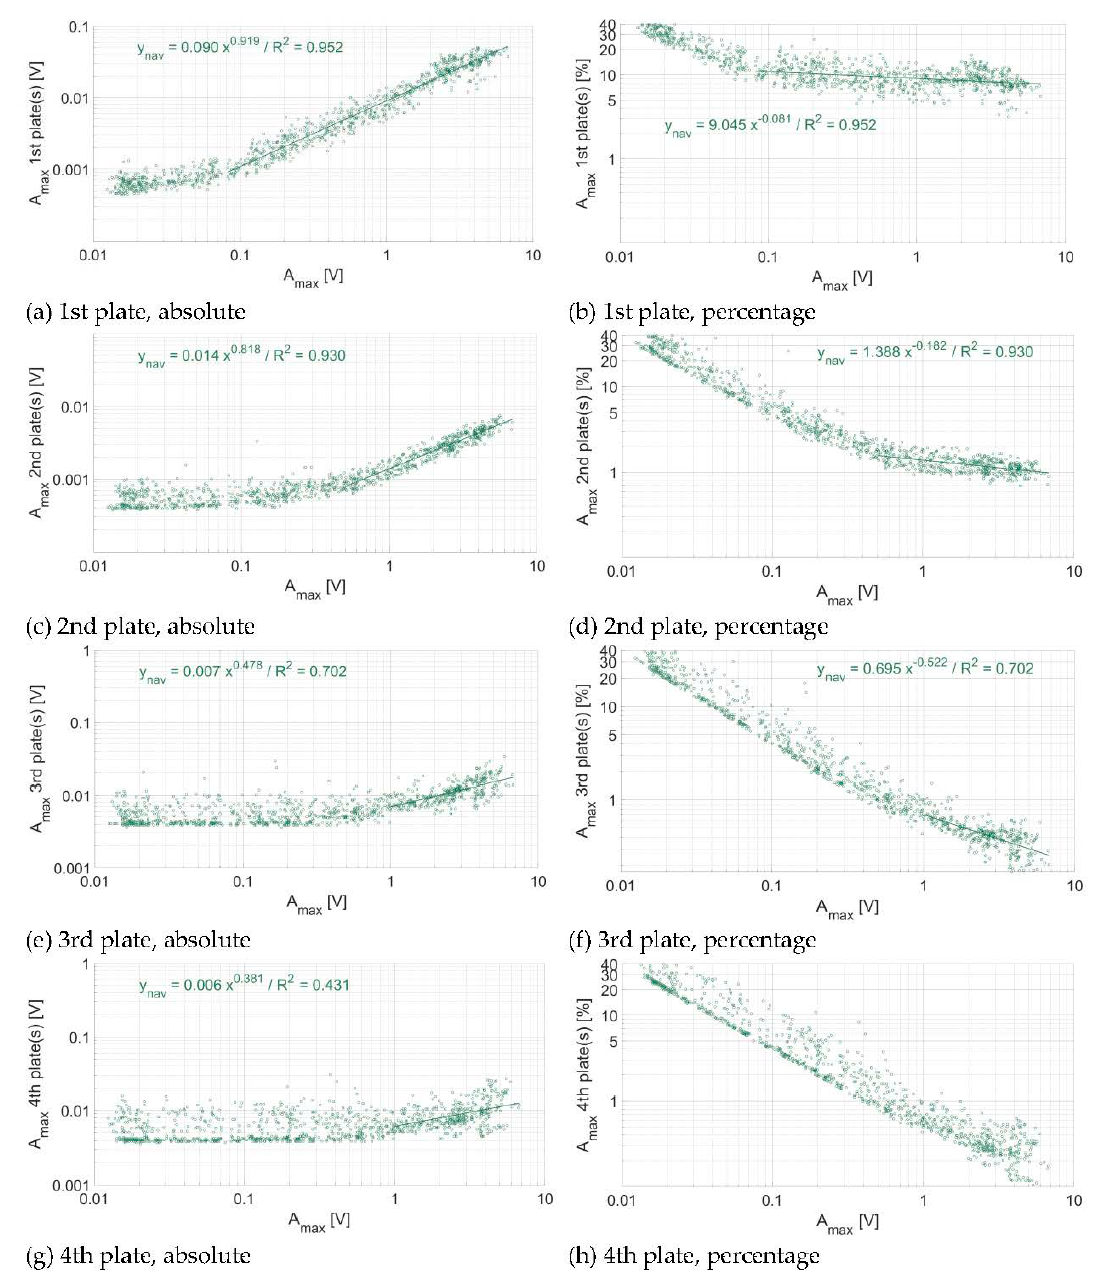
Figure 9. Energy propagation across plates at the Naviscence measuring station ( a , b ) at one plate of distance, ( c , d ) at two plates of distance, ( e , f ) at three plates of distance, and ( g , h ) at four plates of distance, in absolute (left column) and relative (right column) numbers. Each dot represents the voltage associated to a single impact. The regression is fitted only for maximum impact amplitudes greater than 0.08, 0.5, 1 V at one, two, three, and four plates of distance, respectively.